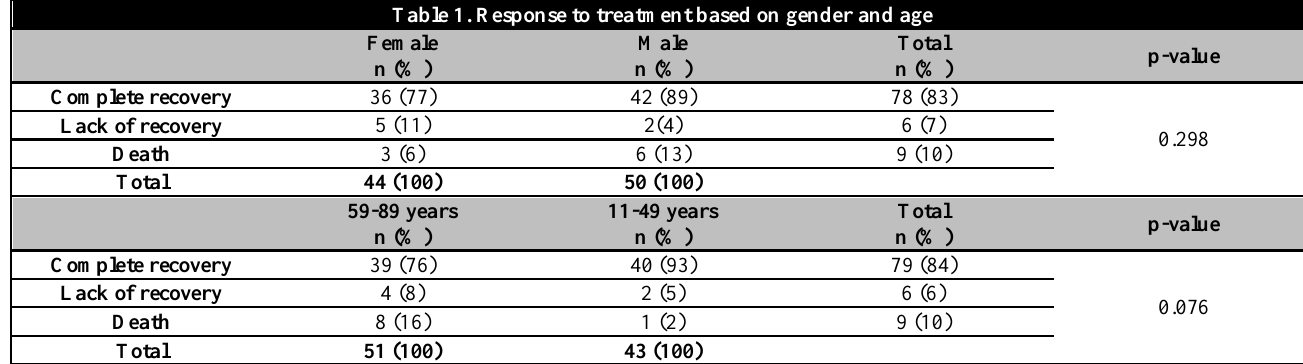
Table 1. Response to treatment based on gender and